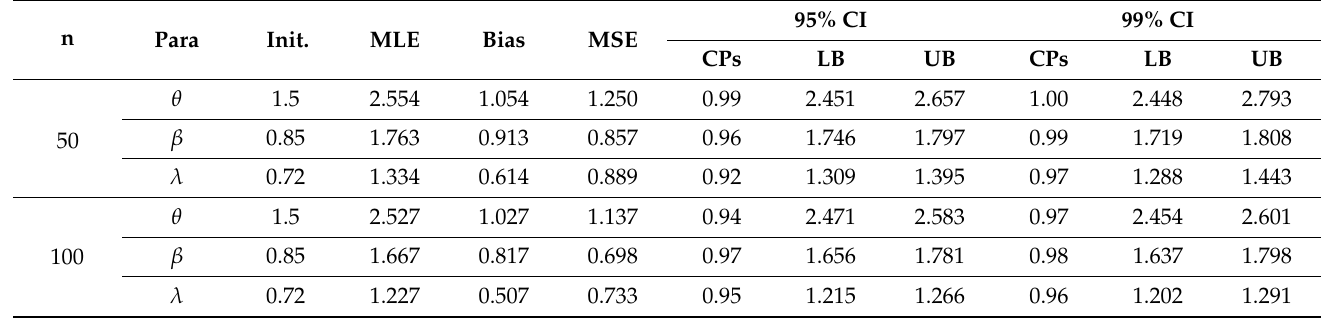
Table 2. The MLEs, Bias, MSE, and CPs for the model parameters of the minLLx distribution based on some initial (Init)